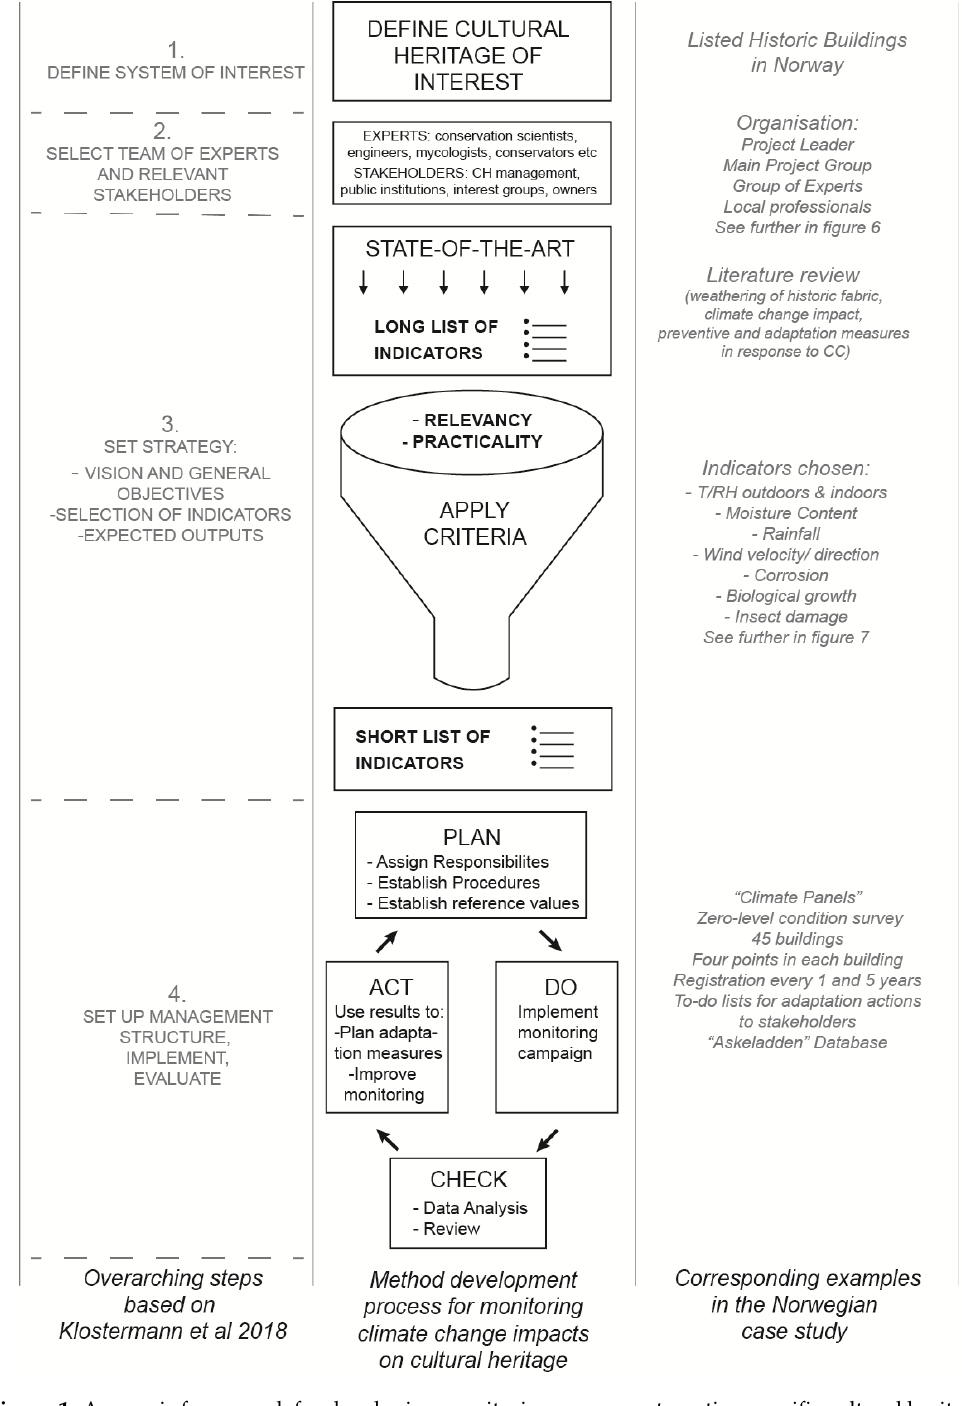
Figure 1. A generic framework for developing monitoring programs targeting specific cultural heritage objects. The first column shows the overarching steps (adapted from Klostermann et al., 2018), the second column shows the method development process for monitoring climate change impacts on cultural heritage, and the third column shows corresponding examples in the Norwegian case study.